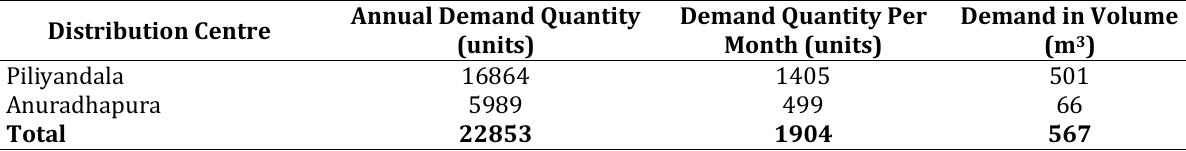
Table 1: Annual sales of Sri Lanka Distribution